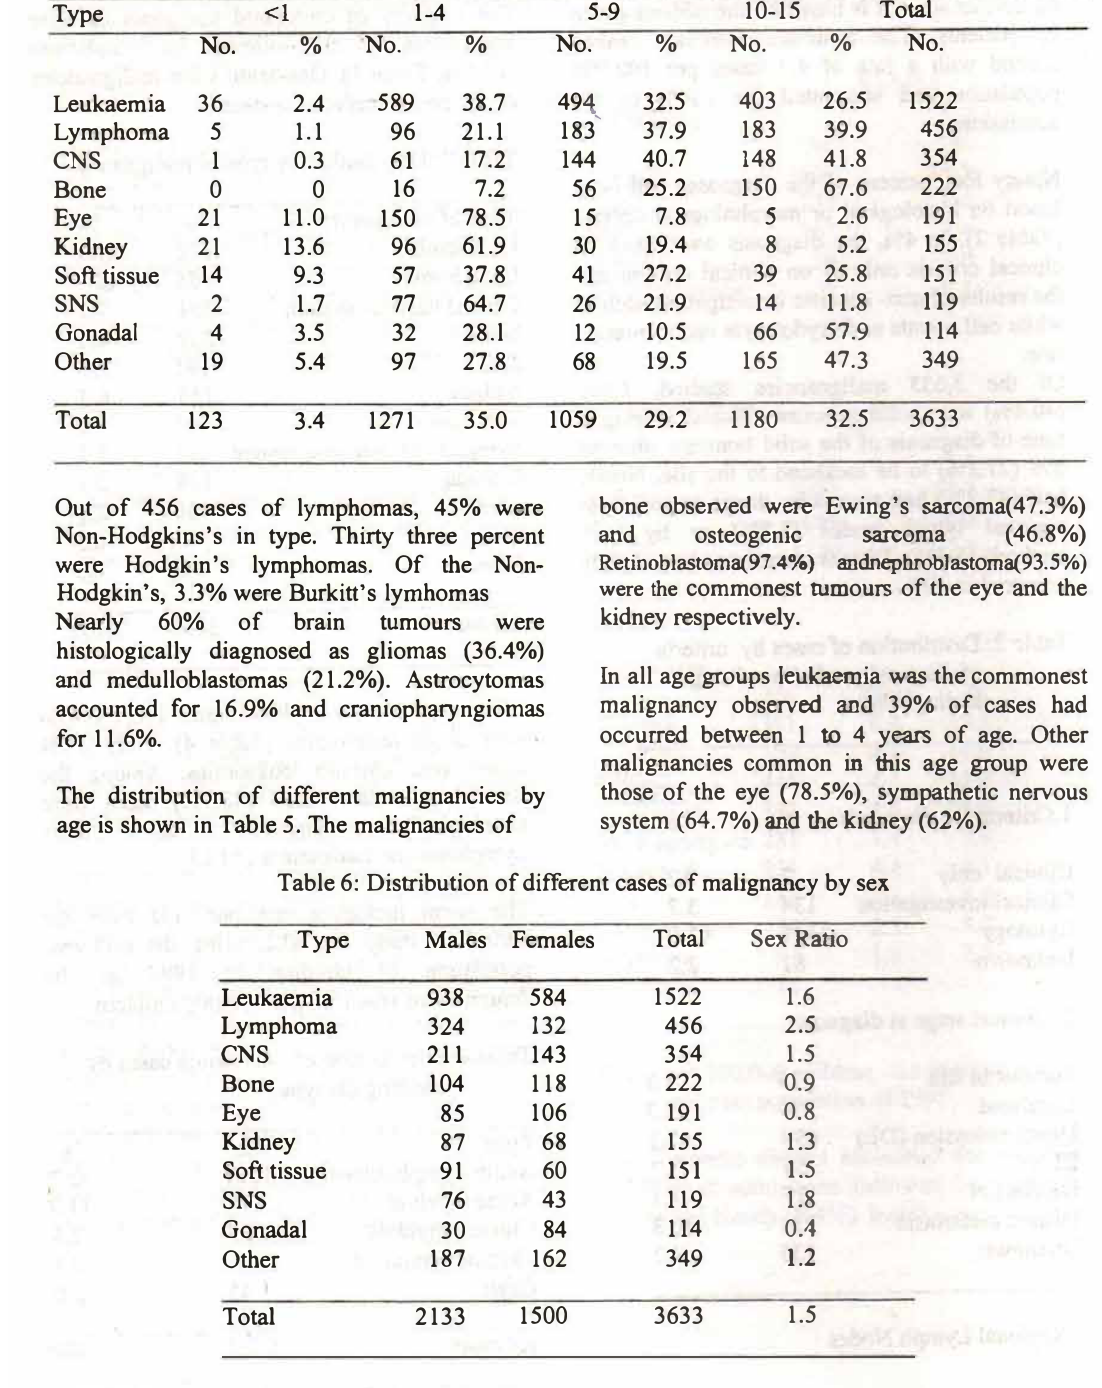
Table 6: Distribution of diff e rent cases of malignancy by